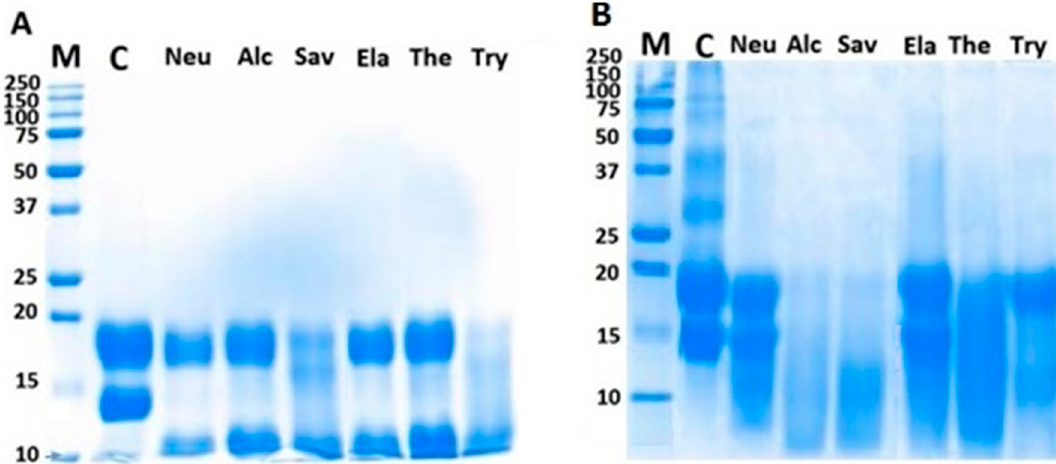
Figure 2. SDS-PAGE on 12% polyacrylamide Tris-Tricine gels. BLG hydrolysates were produced under atmospheric ( A ) and high hydrostatic pressure ( B ) with various enzymes (neutrase (Neu), alcalase (Alc), savinase (Sav), elastase (Ela), thermolysin (Ther), and trypsin (Try); M , standard marker; C, unhydrolyzed β -lactoglobulin (BLG).